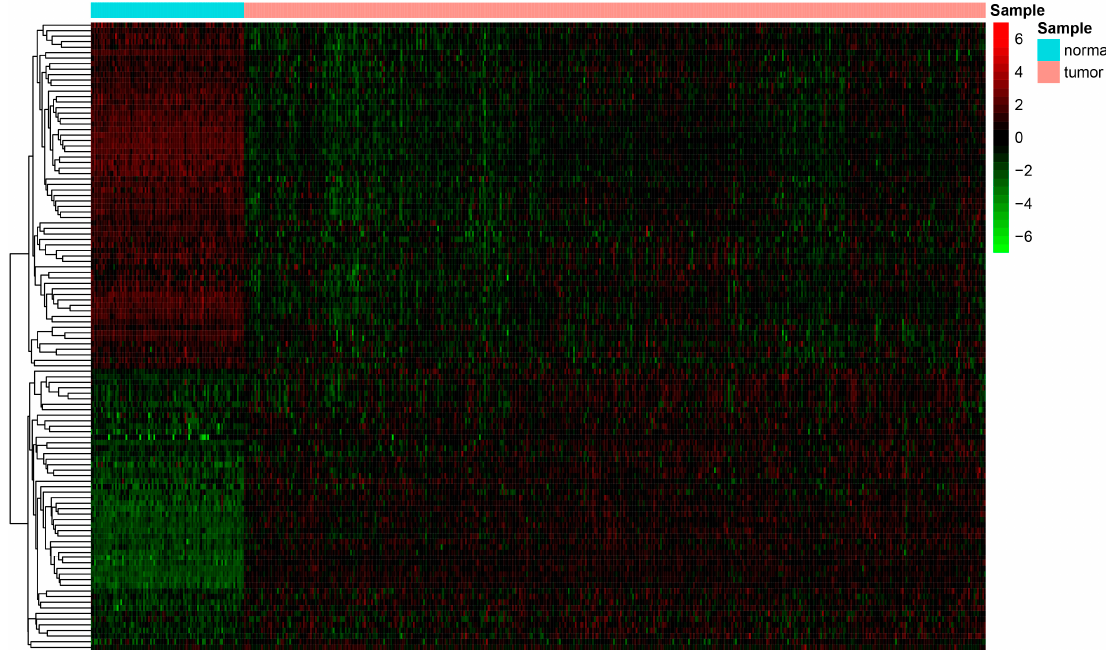
Figure 1. Heatmap depicting differentially expressed ferroptosis-related